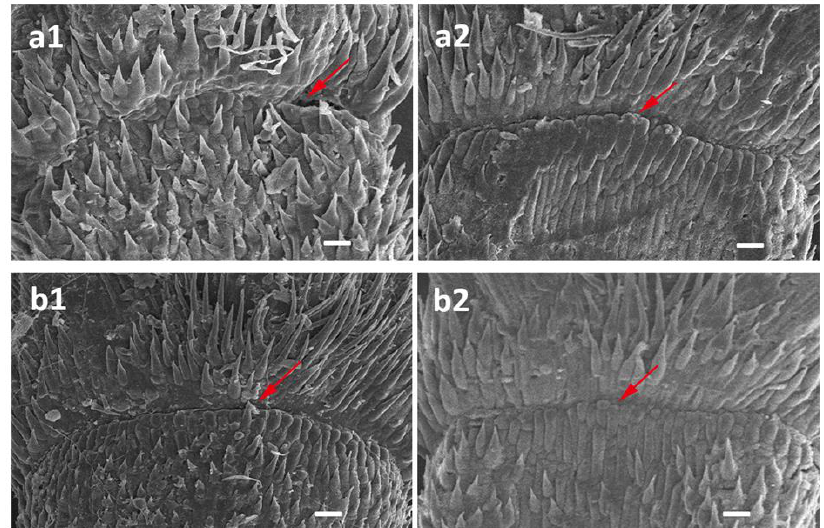
Figure 9. Histological structures showing variations in abscission formation in awned and de-awned Siberian wildrye accessions. ( a1 , a2 ) scanning electron photos of awned ( a1 ) and de-awned ( a2 ) seeds of ZNO3. ( b1 , b2 ) scanning electron photos of awned ( b1 ) and de-awned ( b2 ) seeds of LT02. Red arrows indicate the location of the abscission layer.